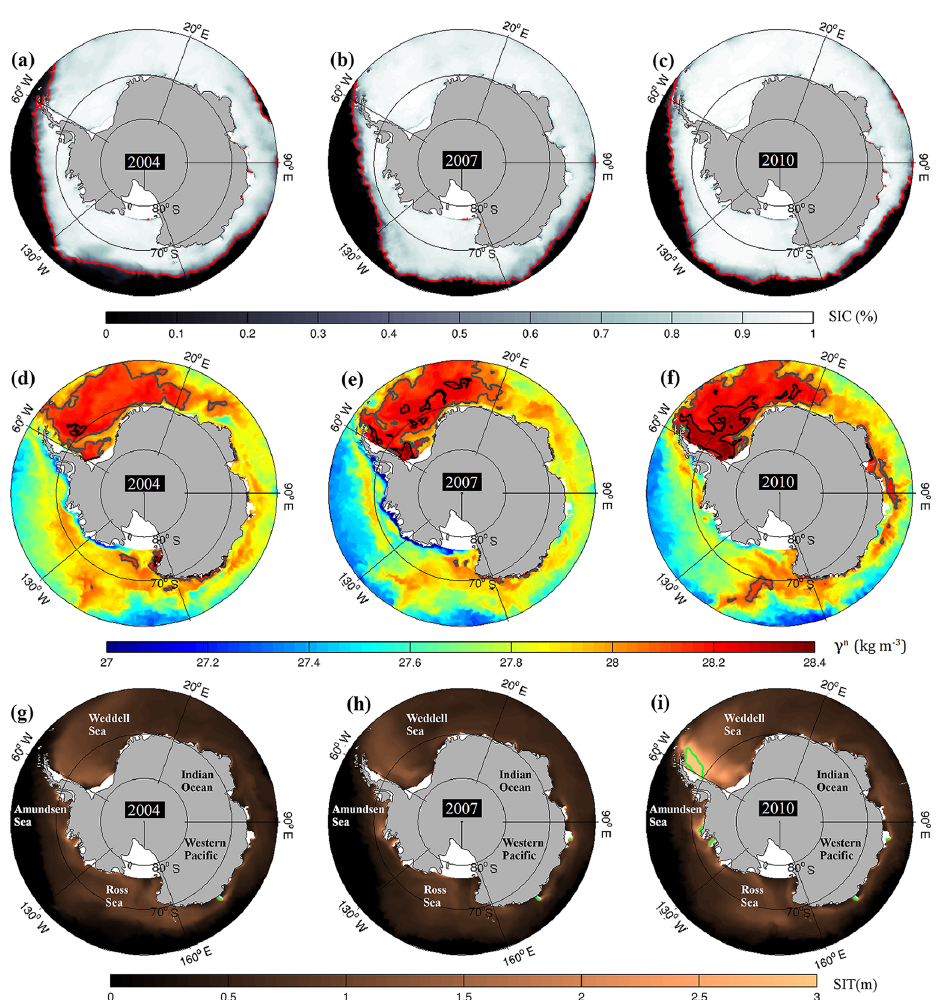
Figure 14. (a) , (b) and (c) : the mean UR025.4 sea ice concentration in September of 2004, 2007 and 2010, respectively. The red line marks the 30% SIC contour. (d) , (e) and (f) : the neutral density contours at 700m depth in September of 2004, 2007 and 2010. The gray lines delineate the 28.1kgm − 3 neutral density of WDW and the black lines the 28.27kgm − 3 of the WSDW. (g) , (h) and (i) : monthly sea ice thicknesses of UR025.4 in September of 2004, 2007 and 2010, respectively. The green line marks the 3.5m sea ice